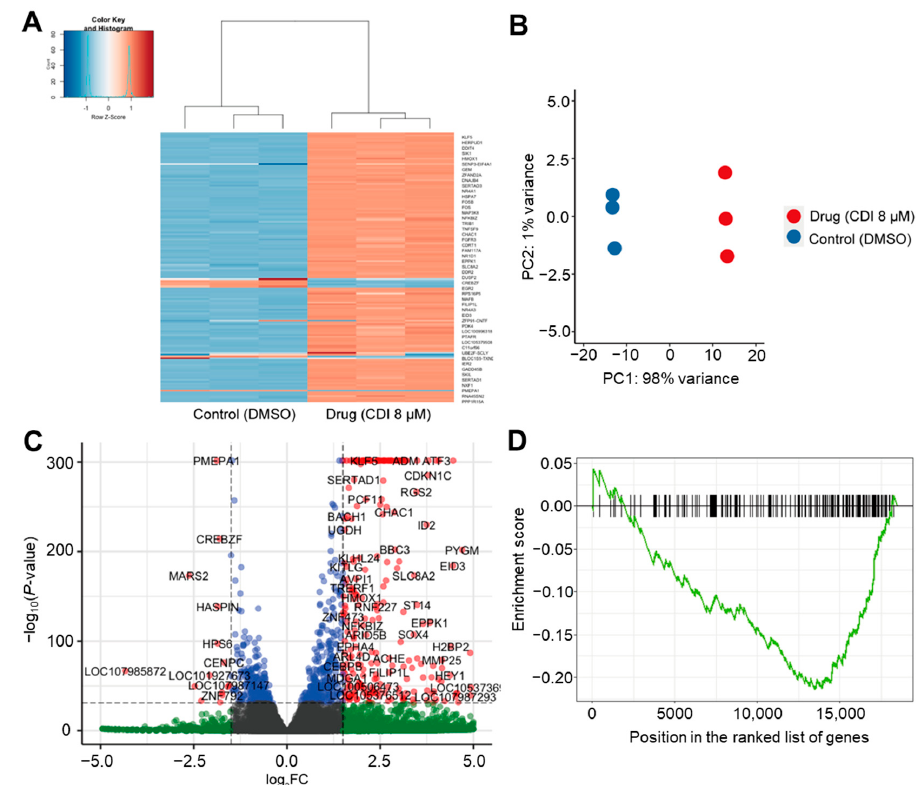
Figure 5. RNA-Seq analysis of MDA-MB-231 cells at the 6-h time point with 8 μ M CDI or DMSO solvent. ( A ) Clustered heat map illustrating the normalized expression level of genes between control (DMSO) and compound treatment (CDI 8 µ M) groups. ( B ) PCA analysis of gene expression profiles, showing the similarity between control (DMSO) and compound treatments (CDI 8 μ M). ( C ) Volcano plot depicting the –log 10 ( p -values) across biological triplicates for the fragment per kilobase per million read fold changes. Each point represents a transcript mapped to the human genome. Significantly upregulated and downregulated transcripts are colored in red. The threshold for significance was set at p -value < 10 − 32 and log 2 fold change at 1.5. ( D ) Enrichment plots of Gene Set Enrichment Analysis (GSEA) results. MDA-MB-231 cells treated with CDI (8 μ M, 6 h). For GSEA analysis, gene sets of FoxM1 target genes were used that were derived from FoxM1 cistrome based on ChIP-seq experiments [37] .